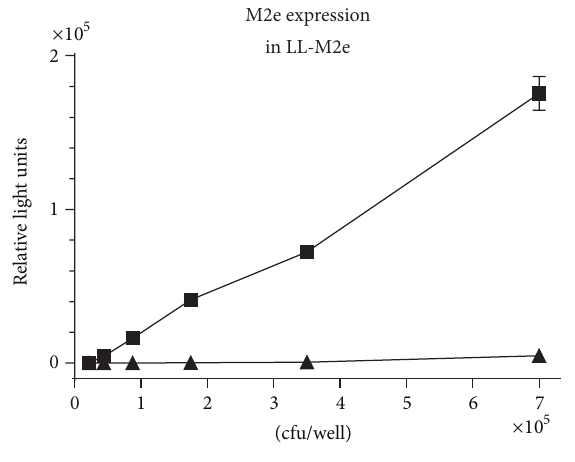
Figure 3: Serum response. Serum was collected 1 week after final vaccination and analyzed for M2e-specific serum IgG by ELISA using microtiter plates coated with 2 𝜇 g/mL M2e peptide. The plates were developed with goat antichicken IgG-horseradish peroxidaseconjugateandchemiluminescentsubstrate.Luminescent signal from each sample was converted to concentration of chicken IgG by extrapolation from the graph of luminescence versus IgG concentration of the standards and corrected for sample dilution. Each sample was analyzed at two or three different dilutions, and each dilution was analyzed in duplicate. Group mean M2e-specific IgG concentration is